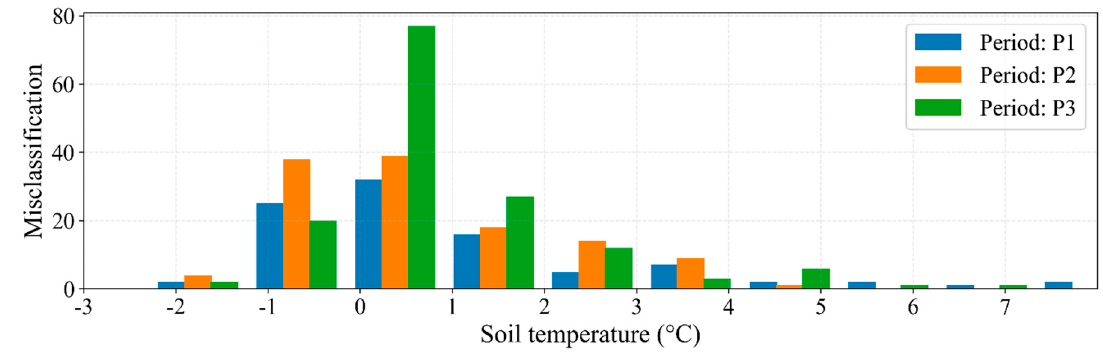
Figure 8. Frequency histogram of the observed soil temperatures for the incorrectly discriminated pixels.